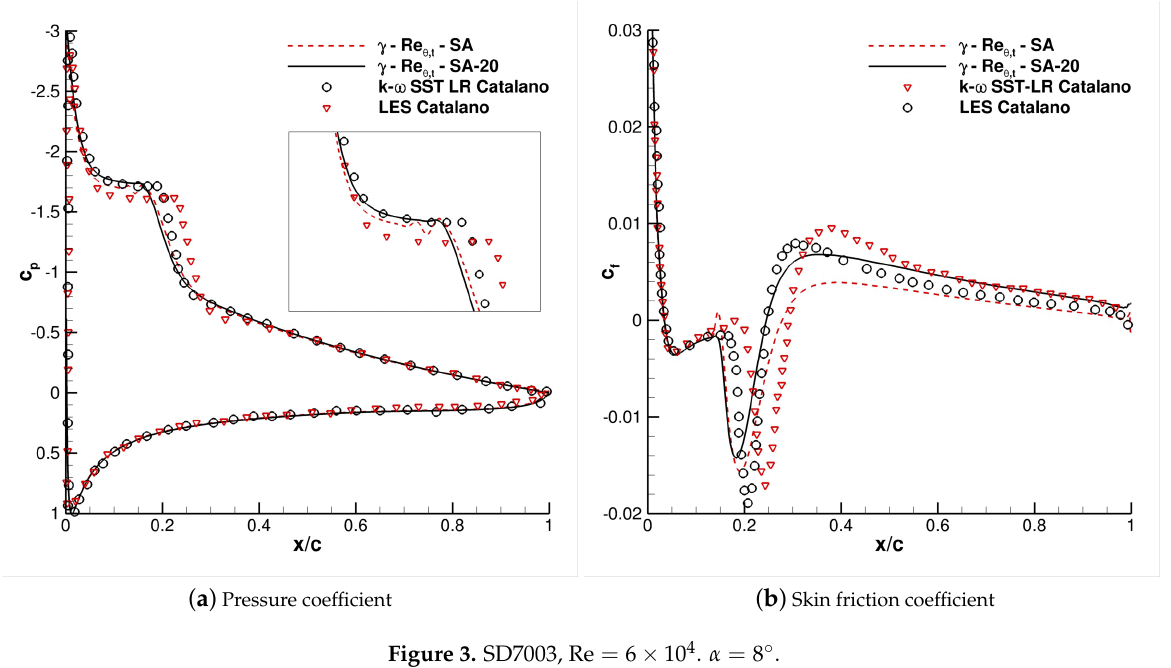
Figure 3. SD7003, Re = 6 × 10 4 . α = 8 ◦ .